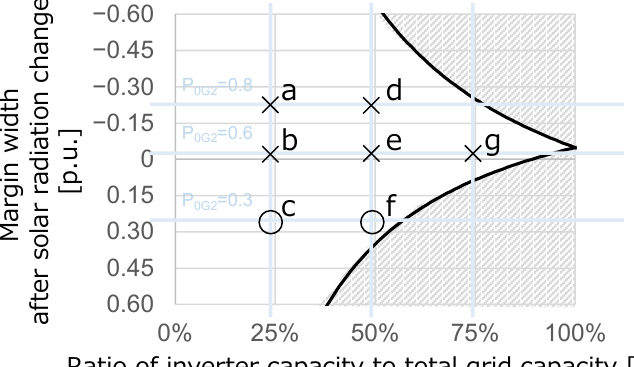
Figure 15. Stability result of the ramp changing irradiance PV-VSM without limiter control. In this figure, a–g corresponds to the labels of the simulation case. ◦ and × mean stable and unstable results.